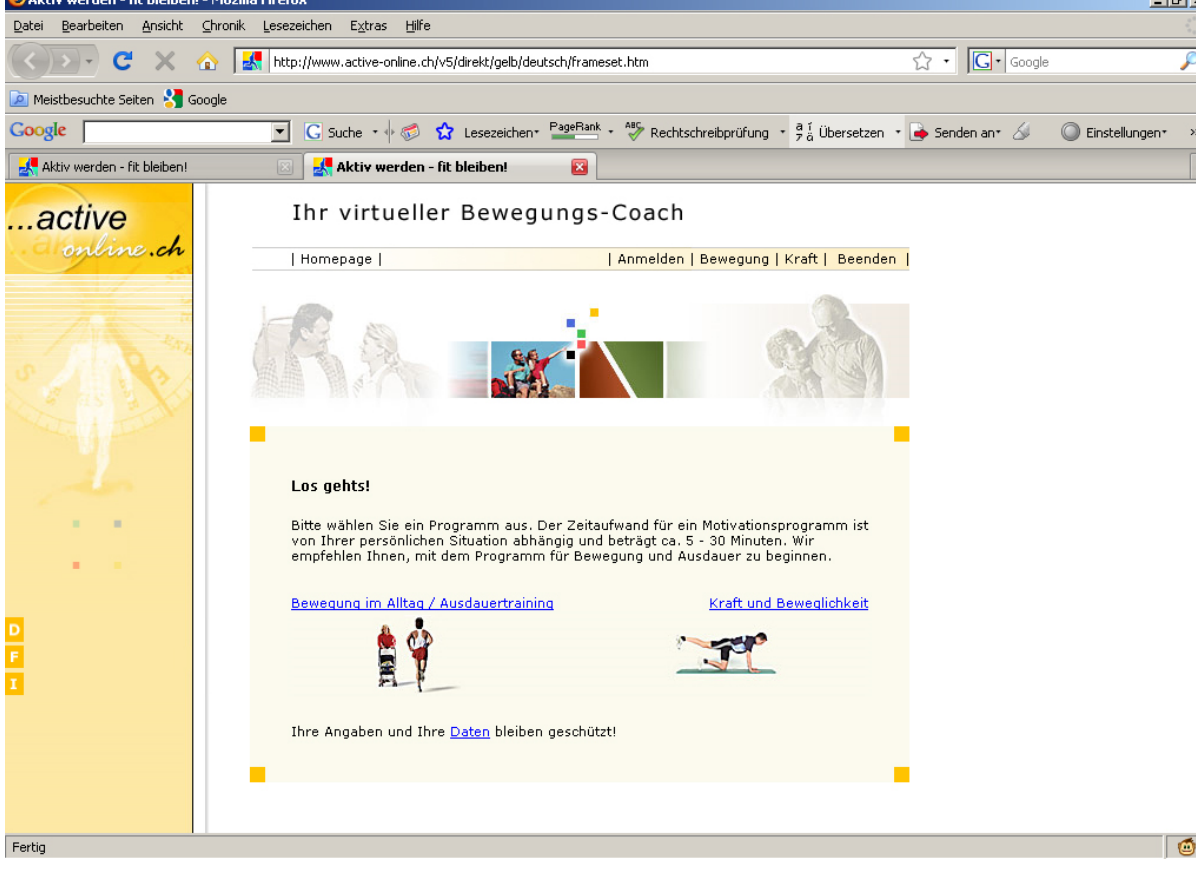
Participants in the CG were forwarded to a nontailored website with general information on physical activity and health with no additional reminder emails. This was a static website with some tips on how to include more physical activity in daily life